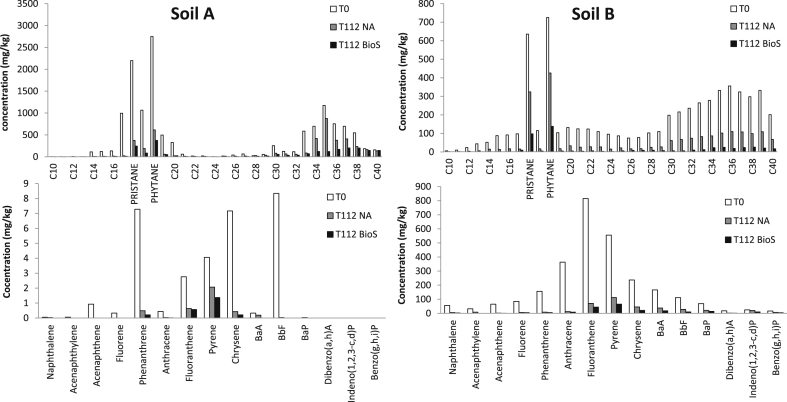
n-alkanes and PAH fingerprints in soil A and B respectively after 112 days of natural attenuation (T112 NA) and biostimulation treatment (T112 BioS).